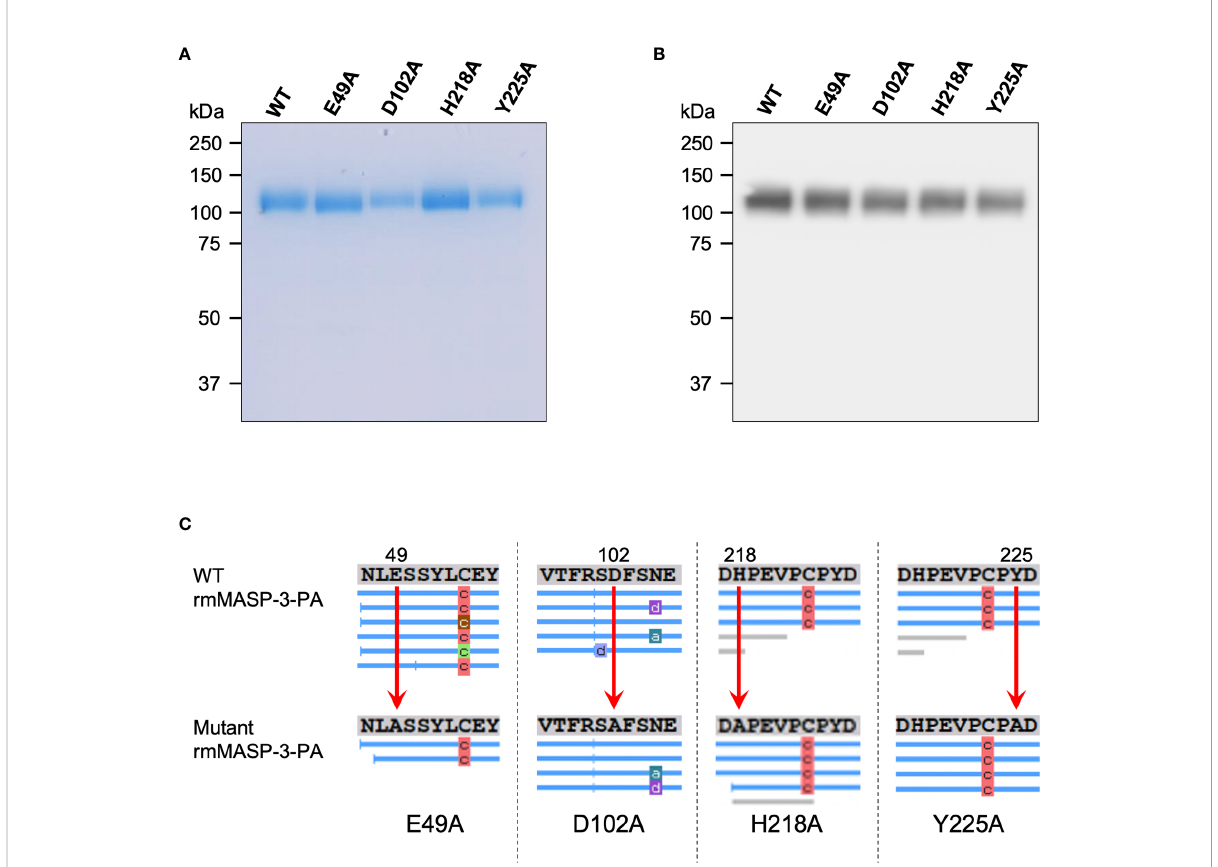
FIGURE 2 Expression and puri fi cation of WT and mutant rmMASP-3-PAs were con fi rmed by SDS-PAGE under reducing condition followed by InstantBlue staining (A) and Western blotting using anti-mouse MASP-3 L-chain antibody (B) . (C) The results on mass spectrometric analyses revealed the substitutions of target amino acids in rmMASP-3-PA (E49, D102, H218 or Y225) for alanine, as indicated by the red arrows. The blue lines below the amino acid sequences show the fragments detected by the mass spectrometry. The characters on the blue line represent as follows: “ a ” means ammonia-loss, “ c ” means carbamylation, and “ d ” means deamidation of the corresponding peptides in the peptide fragment, which are due to protease treatment prior to analysis with mass